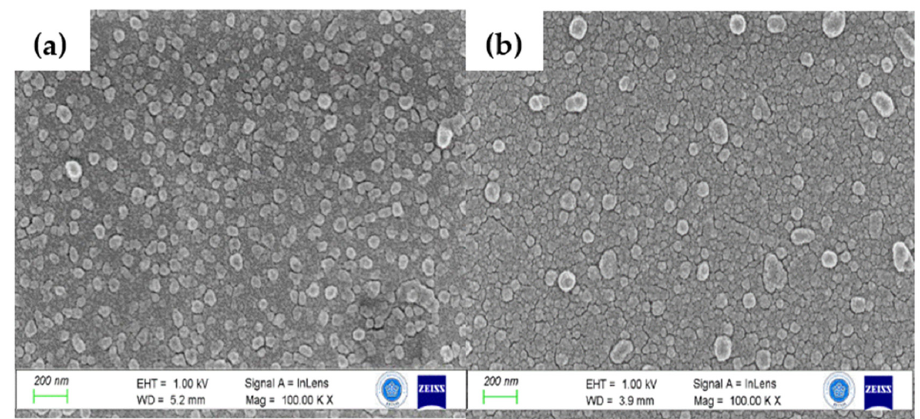
Figure 4. ( a , b ) FE-SEM morphology of MoS 2 and WS 2 thin films. The topography of the prepared samples was measured by AFM using a noncontact mode of a 1 × 1 µm area. Figure 5a,b show the 3D AFM topography and the horizontal line profile of MoS 2 and WS 2 samples, respectively. The roughness values of MoS 2 and WS 2 are 10.689 and 2.761 nm, respectively, as depicted in Table 1. The optical microscopy analysis also shows that MoS 2 has higher surface roughness than WS 2 film.